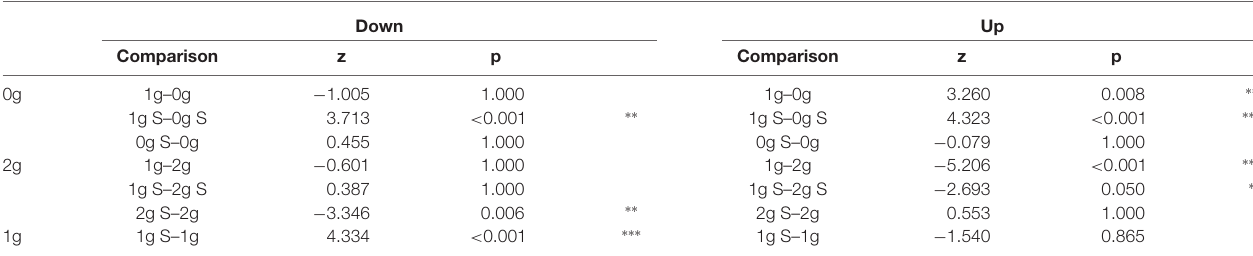
TABLE 3 | Post hoc analysis for maximum